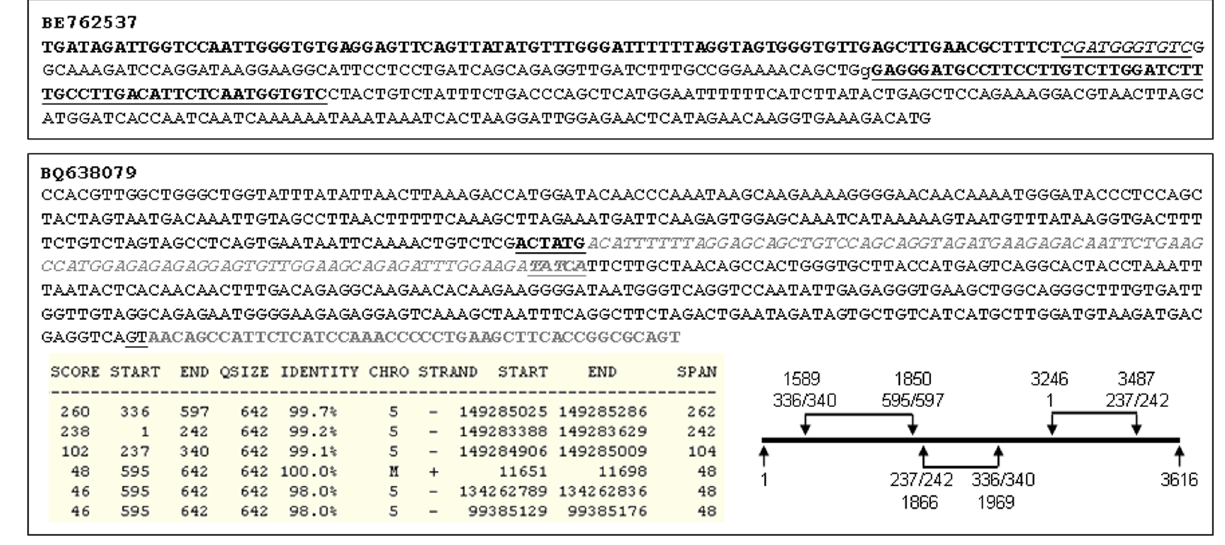
Figure 2. Examples of trimeric and tetrameric ESTs with or without an mt-sequence. Top panel : AI924910 is a trimera. Its 1–156th, 155– 342th, and 341–550th nt regions match, respectively, the 5468–5676th nt region of the CYCO1 mRNA from chromosome 3, the 4332–4518th nt region of the PDCD11 mRNA from chromosome 10 (underlined and boldfaced), and the 366–521st nt region of the SREK1IP1 mRNA from chromosome 5. Between the two neighboring partners, there are two nt (lowercase letters) overlapped. Middle panel : BE762537 is a tetramera. Its first 86 nt (boldfaced) match the 2198–2283rd nt of the L-strand of mtDNA. The following 11-nt sequence (italicized and underlined) is an unmatchable gap. Its 98–168th nt sequence is part of the alternatively spliced exon 2 of the UBC mRNA from chromosome 12, which is followed by a 53-nt (the 268–220th) UBC antisense fragment (boldfaced and underlined). Both UBC sense and antisense fragments, which overlap at the 168th nt (the lowercase ‘‘g’’), have multiple repeats in the UBC mRNA (not shown). The last 149-nt (the 221–369th nt) sequence is part of the ENPP6 mRNA from chromosome 4. Bottom panel : BQ638079 is a 642-bp tetrameric EST. Its first 595–597 nt sequence consists of three fragments from intron 7 of the PDE6A gene on the minus strand of chromosome 5. The relationships among these three fragments within this 3616-bp intron are illustrated in the figure, with the 3-digit numbers indicating the 5 9 or 3 9 end of each fragment and the 4-digit numbers indicating the position at the intron. As shown in the sequence, the figure, and a table copied from the UCSC browser, the middle fragment is 104-bp long, is matched to the 1866–1969th nt region of intron 7, and shares 6 or 5 nt (the underlined and boldfaced 237–242nd or 336–340th nt) with its up- or down-stream fragment that actually comes from the 3 9 or the 5 9 part, respectively, of the intron 7. The last 46–48 nt sequence of this EST come from the H-strand of mtDNA, with 2 nt (underlined GT in the sequence) overlapped with the last fragment of intron 7 of the PDE6A. The mt-sequence has two highly homologous NUMTs on chromosome 5, as shown in the table.